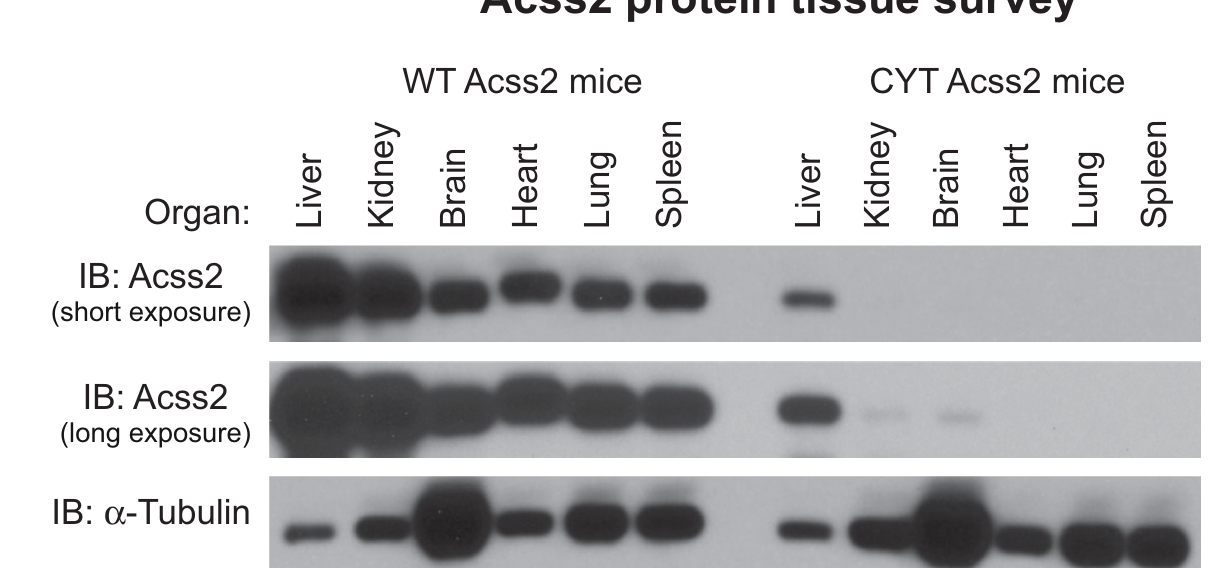
Fig 5. Acss2 protein levels are globally reduced in ED Acss2 mice. Tissue survey of ED mice reveals global reduction or absence of Acss2 protein in liver, kidney, brain, heart, lung, and spleen. Short and long exposures of Acss2 protein immunoreactivity are shown normalized to protein amount and compared to immunoblot of α